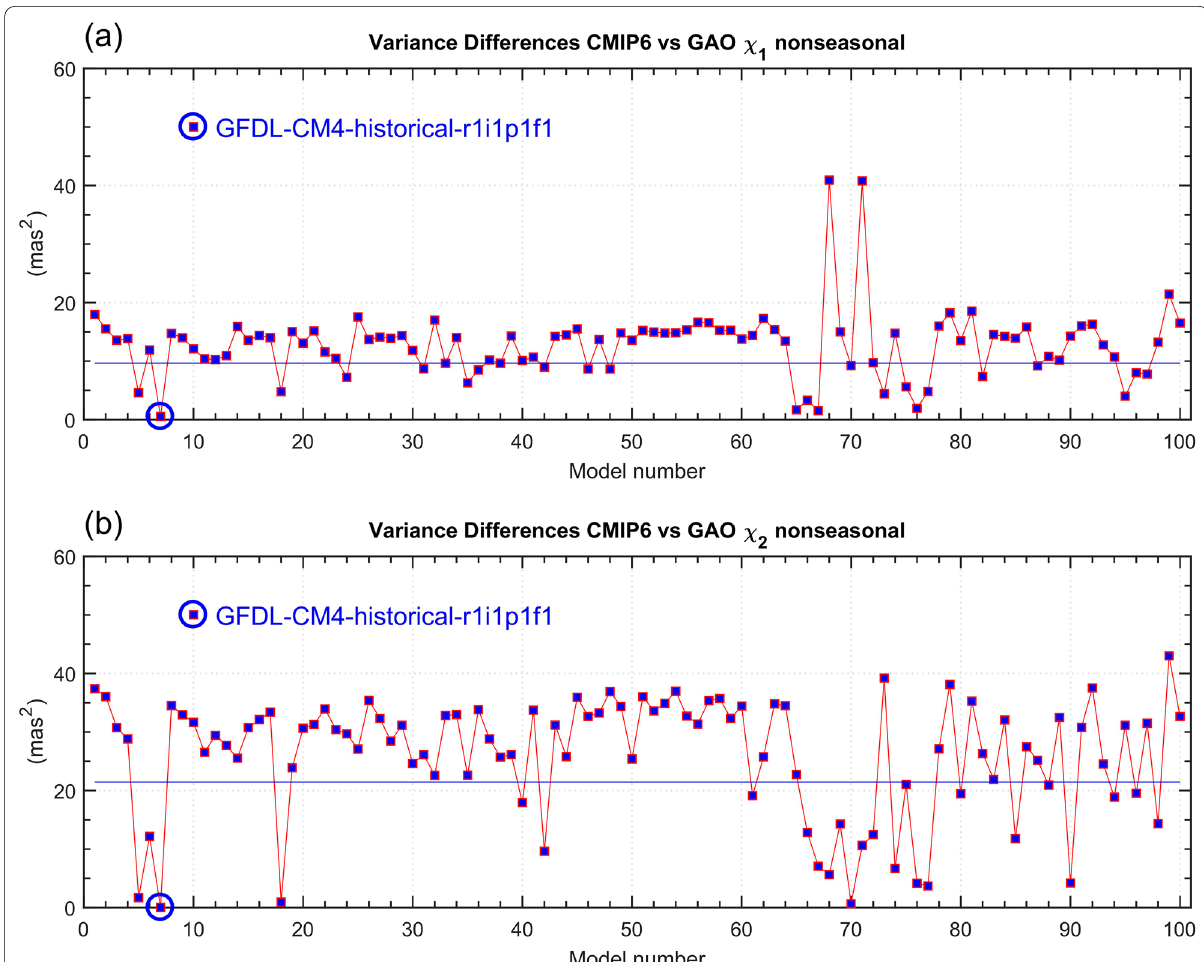
Fig. 10 Absolute values of differences in variance between GAO and HAM from CMIP6 for a χ 1 non-seasonal component and b χ 2 non-seasonal component. Blue lines represent the first quantile. The model with the smallest variance differences is indicated by a circle and label